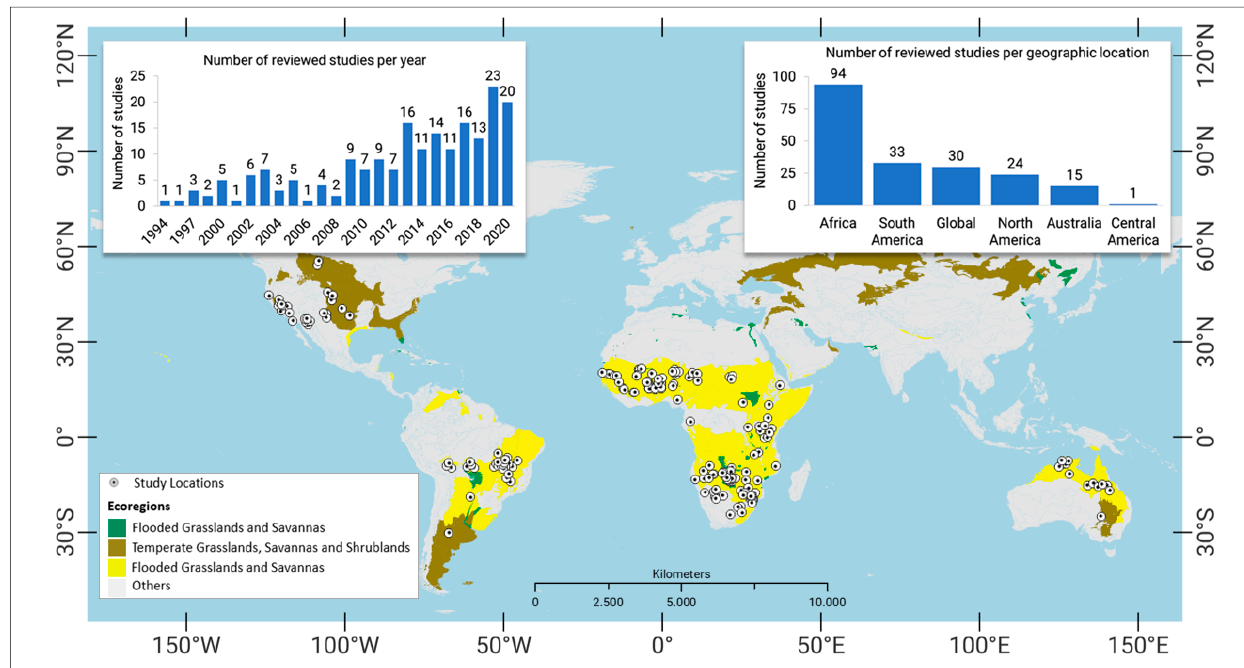
Figure 3. Global distribution of savanna biomes, study sites, and number of studies per geographic area (Terrestrial ecoregions of the world map is modified from Hengl et al., 2018, and incorporated with updated boundary maps of Cerrado and Caatinga derived from the National Institute for Space Research (INPE) products from Aguiar et al., 2016. Some of the study locations seem to be outside of the savanna biome because of scale mismatches (the global mapping scale versus savanna patches occurring at smaller and local scales). This is evident in areas with smaller savanna patches with a high number of reviewed papers, such as the California oak savannas. Another reason is because of the variable definition in the biome classification used, as it does not account for the oak savannas in north America, such as the California oak savanna and the southwestern oak savanna.